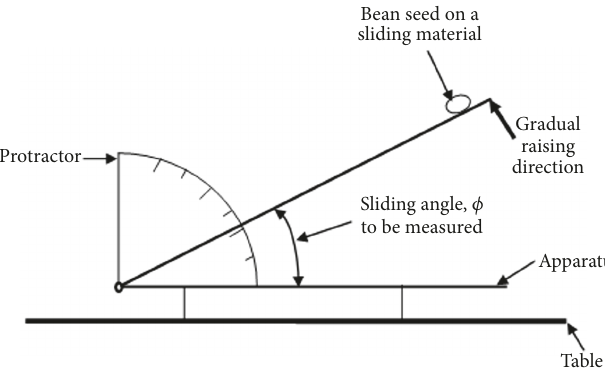
Figure 3: Setup for measuring common beans sliding angles.